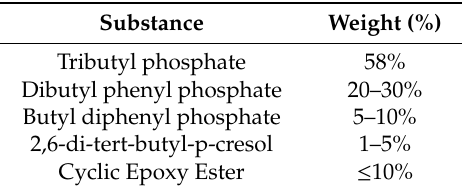
Table 1. Main ingredients in the widely used family of hydraulic fluids marketed under the brand name Skydrol [1–3].